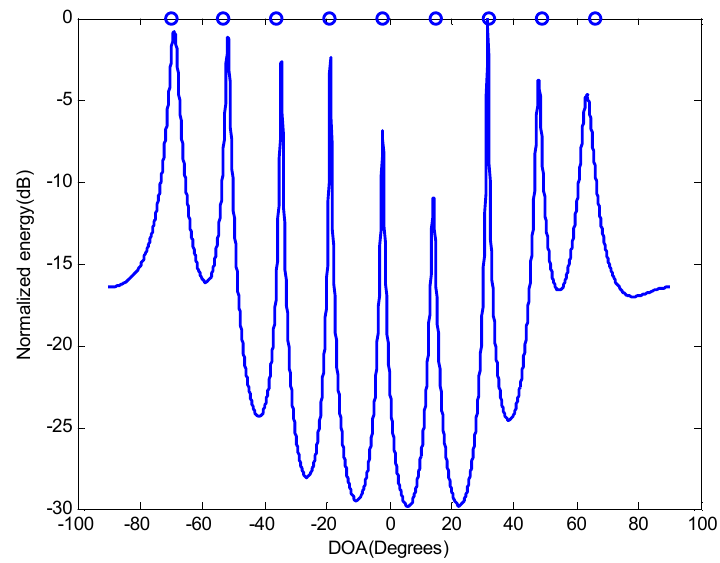
Figure 3. Spatial spectrum for underdetermined DOA estimation, K = 9, N = 8.